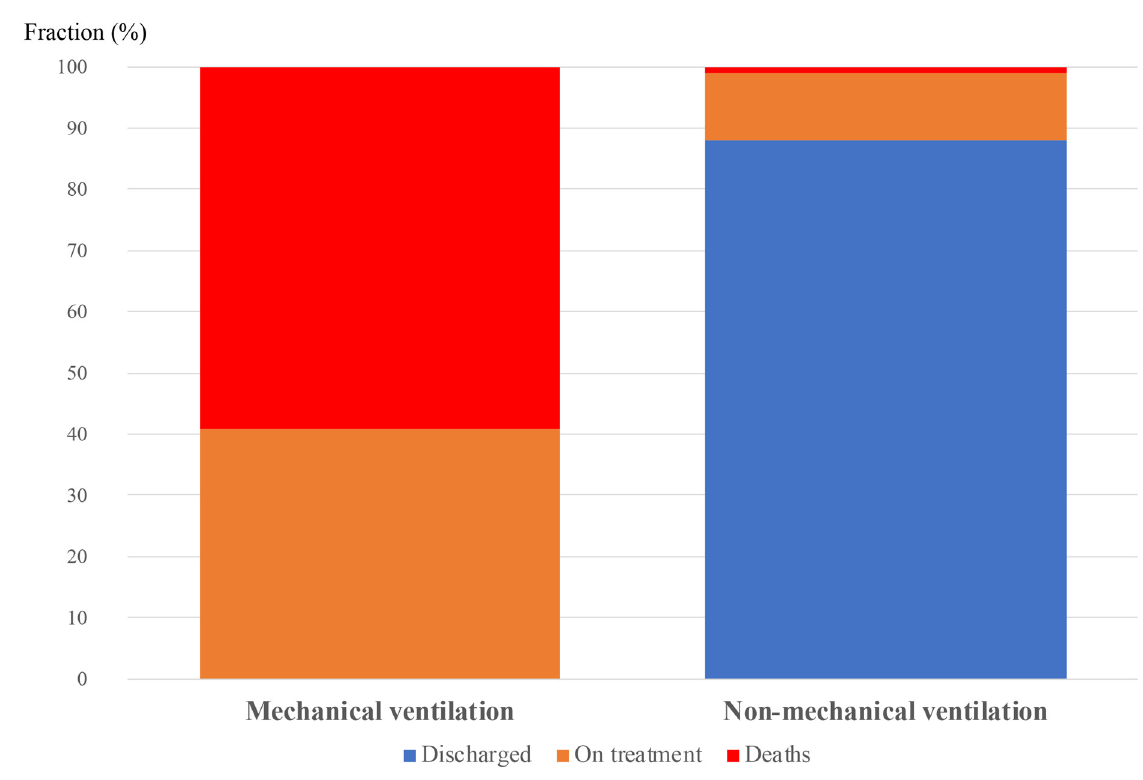
Figure 3. Clinical outcomes according to use of mechanical ventilation before TCZ administration. Outcomes are shown for the 17 patients who were on mechanical ventilation and 62 patients who were not on mechanical ventilation before TCZ therapy. Proportion of deaths is in red, proportion of patients still in hospital is in orange, and proportion discharged from hospital is in blue. Mortality was greater in patients receiving mechanical ventilation (p<0.001 Fisher χ2